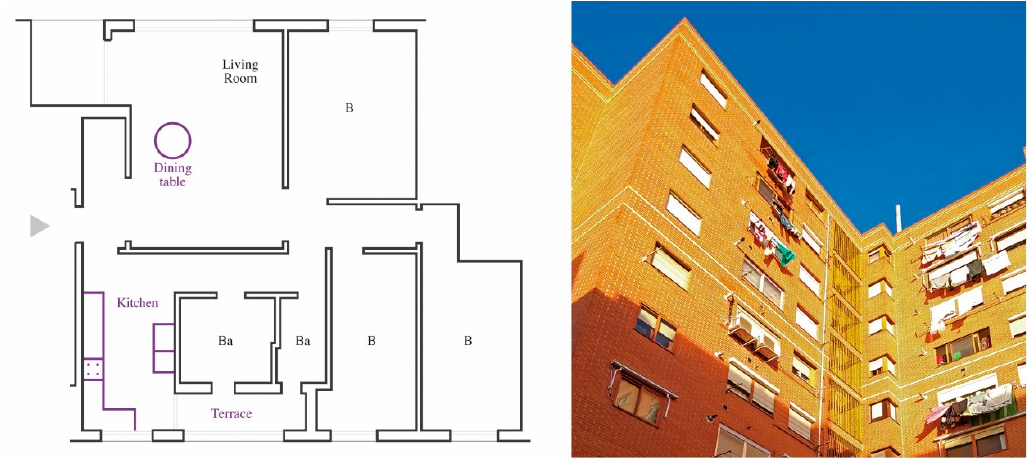
Figure 11. Palomeras residential blocks. Three-bedroom apartment. Plan redrawn and photo by author.